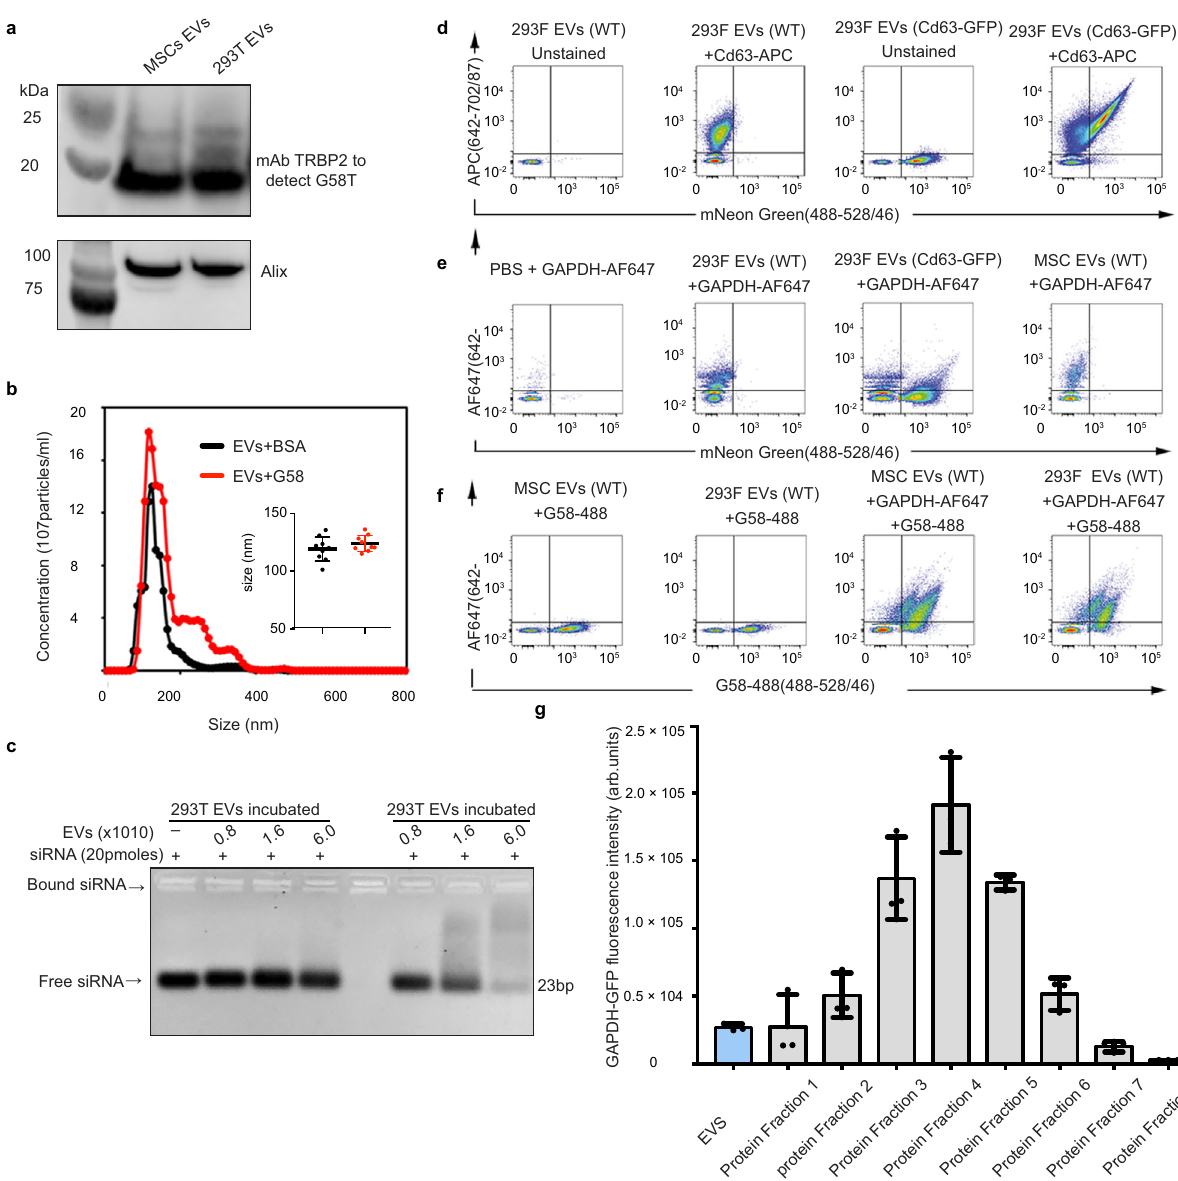
Fig. 2 GAPDH binds to EV surface via G58 domain. a Western blot showing binding of G58 peptide to HEK293T (designated as 293T) and MSC EVs. The second domain of TARBP protein was attached to G58 peptide for detection by anti-TARBP2 antibody. The experiment was independently repeated two times. b NTA pro fi le showing the size distribution of HEK293T EVs after binding to the G58T protein. Inset is the scatter plot representing size (mean) of EVs. Each dot is a mean of three reading frames taken at different timepoints. Data are shown as mean ± s.d ( n = 9 independent biological experiment) Statistical differences were determined by unpaired two-sided Student ’ s t -test, (ns = non-signi fi cant). c Agarose-gel-shift assay of EVs after incubation with either G58T (G58 + dsRBD) protein or dsRBD of TARBP2 protein. siRNA alone was used as negative control to determine interaction of EVs with siRNA. A gradual decrease in the intensity of siRNA re fl ects entrapment of siRNA near the wells due to interaction with G58T EVs. Lack of siRNA binding to dsRBD treated EVs con fi rms G58 peptide mediated binding of protein to EV surface. The experiment was independently repeated three times. d – f High- resolution single EV analysis by Imaging Flow Cytometry (IFC) to determine localization of GAPDH and G58 peptide on EVs. d Represents method validation by using either non-labelled HEK293F derived EVs or neon GFP labelled HEK293:CD63-neon GFP derived EVs as biological reference material. e Detection of GAPDH on HEK293F, HEK293F/CD63-GFP and MSCs EVs, using alexa fl uor 647 labelled anti-GAPDH antibody. f G58 peptide binding on EVs expressing GAPDH on their surface. EVs were incubated with alexa fl uor 488 (af488) labelled G58 peptide and af647 anti-GAPDH antibody. Experiment ( d – f ) were independently repeated three times. FACS sequential gating/sorting strategies is provided as Supplementary Fig. 9. g Distribution of secreted GAPDH-GFP protein in the cell-culture media. Media from HEK293T cells expressing GAPDH-GFP protein were processed to isolate EVs from proteins by gel- fi ltration chromatography. Both EVs and protein fractions contained GAPDH-GFP protein, indicating vesicular and non-vesicular modes of GAPDH secretion. Data are shown as mean ± s.d ( n = 3 independent biological experiments). Source data are provided as a Source Data fi